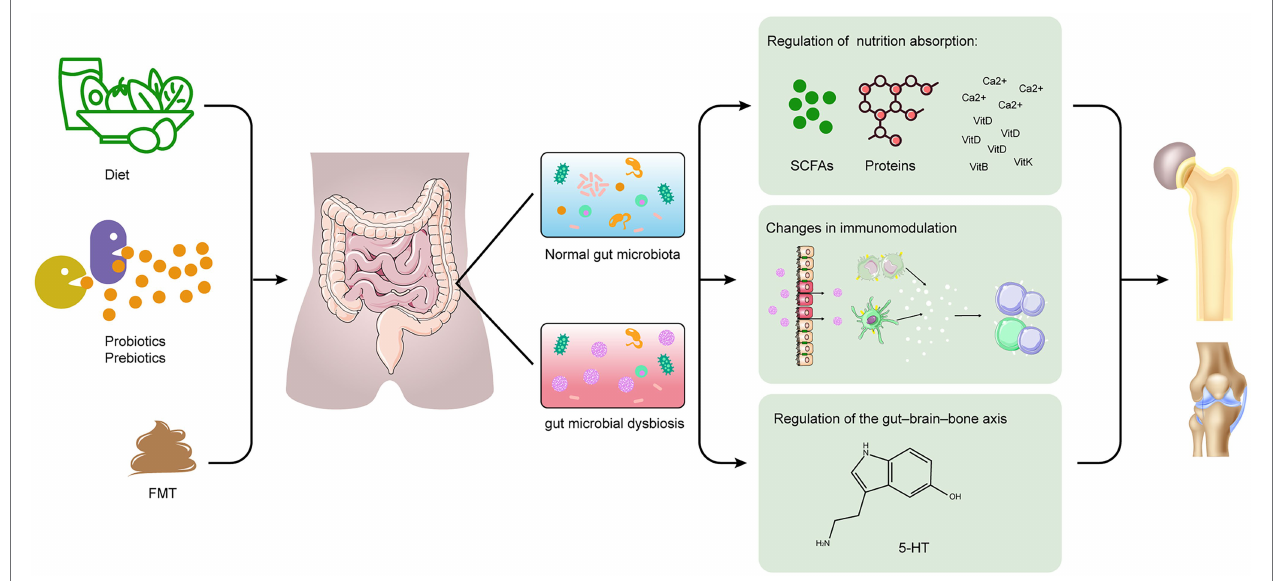
FIGURE 1 | Schematic representation for the role of gut microbiota in bone health and disease. The potential mechanisms include (1) changes in nutrition absorption (i.e., increase in microbial metabolites with health benefits, such as SCFAs); (2) changes in immunomodulation (i.e., regulation of immune cells and cytokines); (3) regulation of the gut–brain–bone axis (i.e., 5-HT). FMT, fecal microbiota transplantation; SCFAs, short-chain fatty acids; Ca, Calcium; VitD, vitamin D; VitB, vitamin B; VitK, vitamin K; and 5-HT,